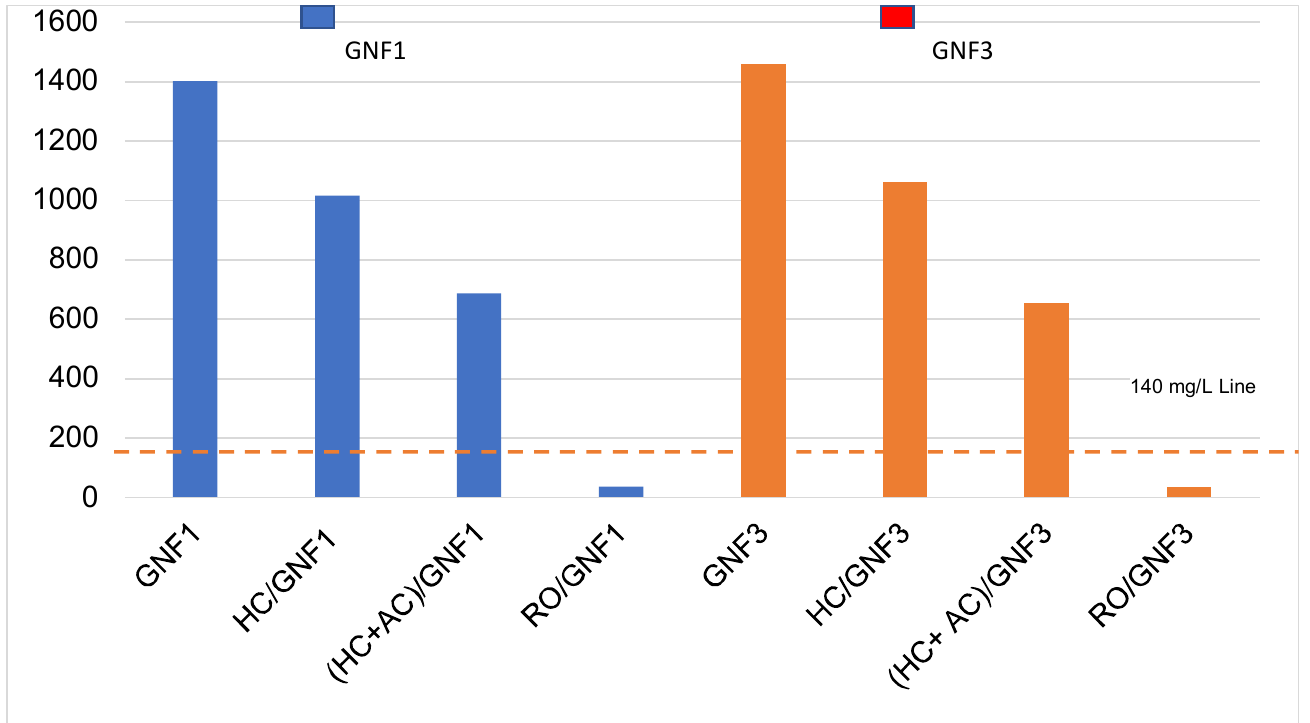
Figure 6. GNF disposal assessment after different treatments.